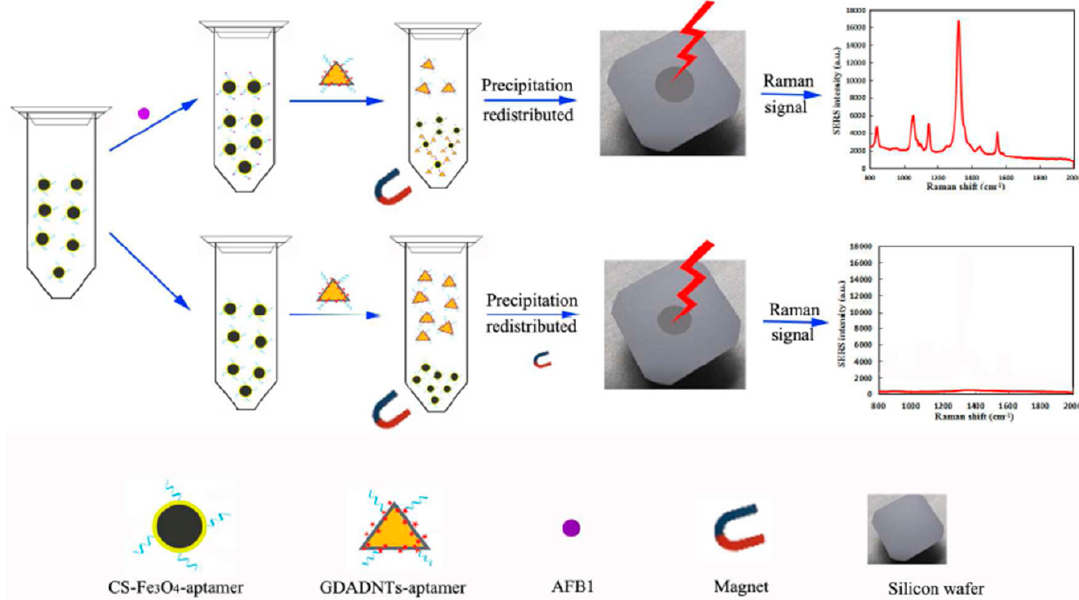
Figure 8. A universal SERS aptasensor platform for trace detection of AFB1. (Reprinted with permission from Elsevier, 2017 [72]).